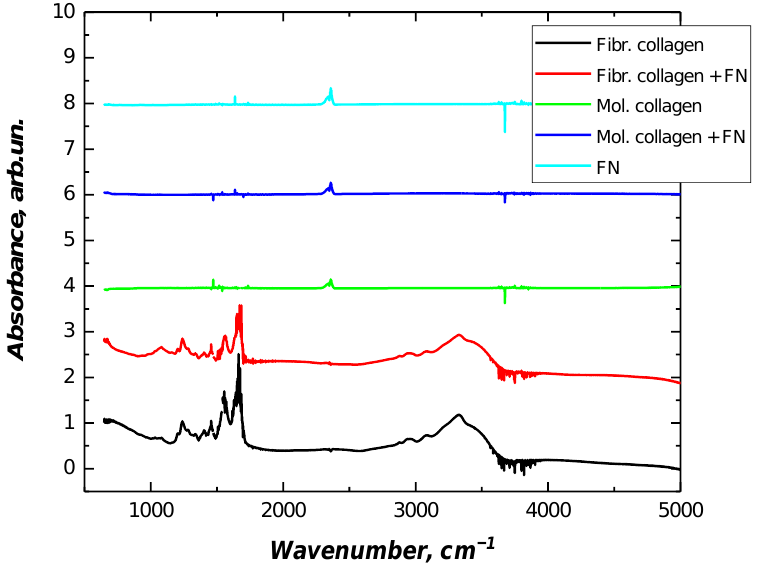
Figure 3. Fourier transform infrared spectra of fibrillar collagen with/without fibronectin.